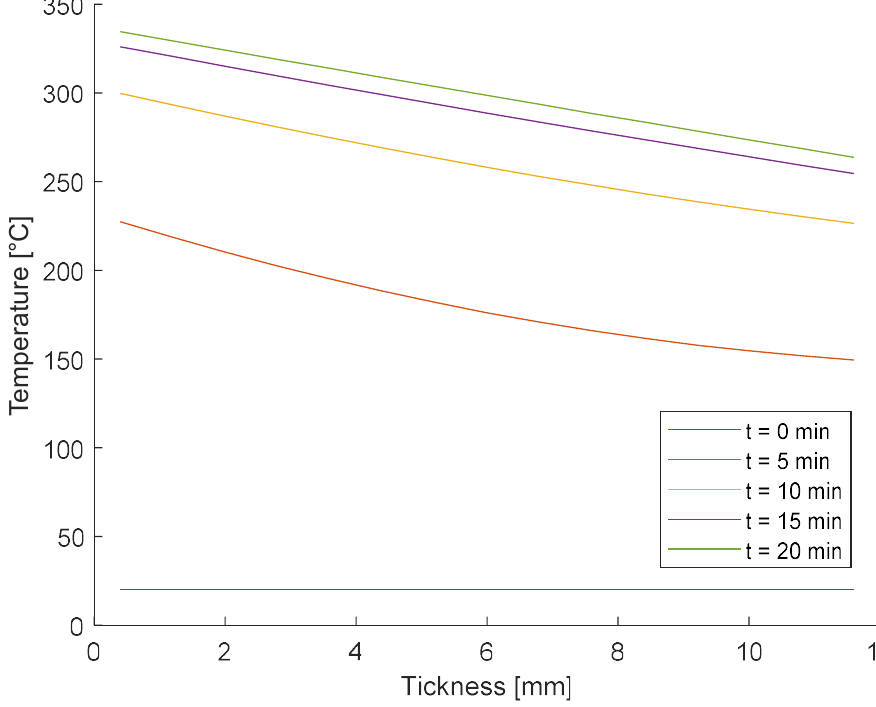
Figure 13. Calculated temperature profiles through the thickness at different times (Test #11).